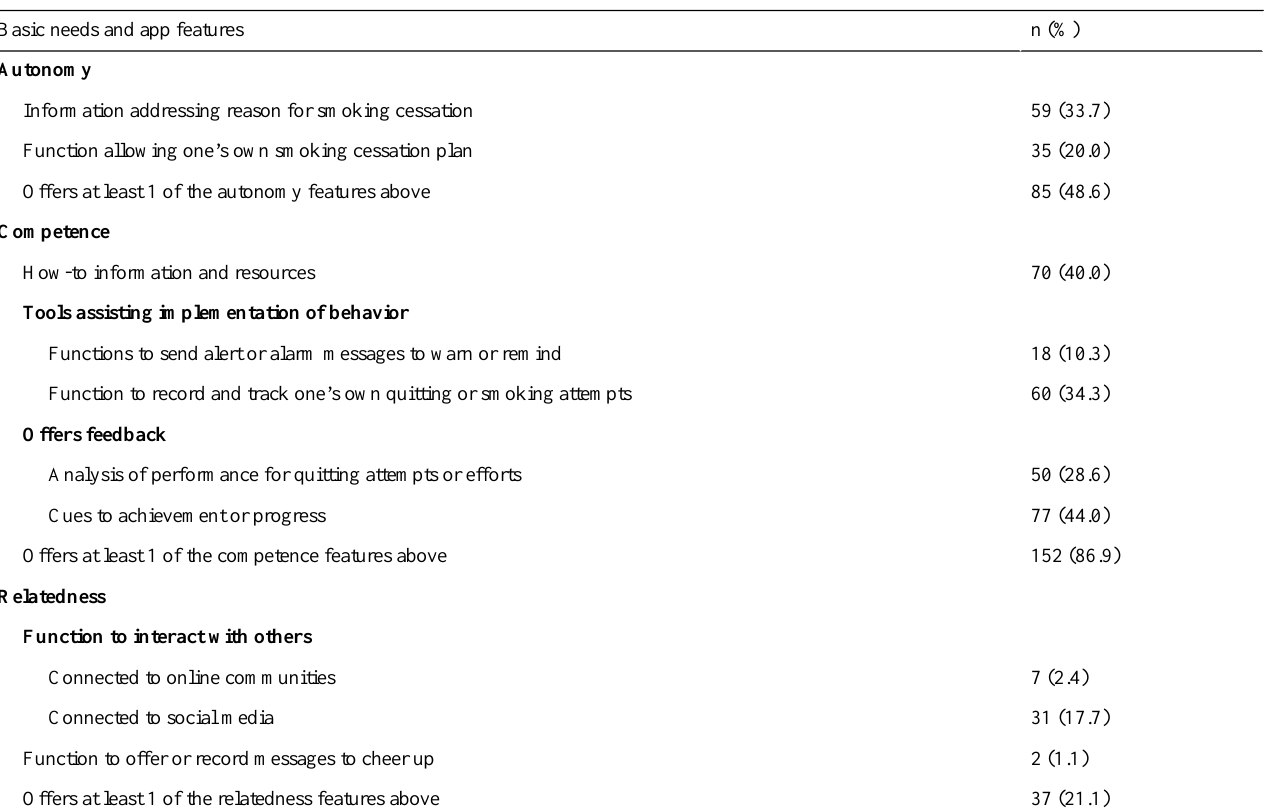
Table 2. Analysis of smoking cessation app features related to basic needs